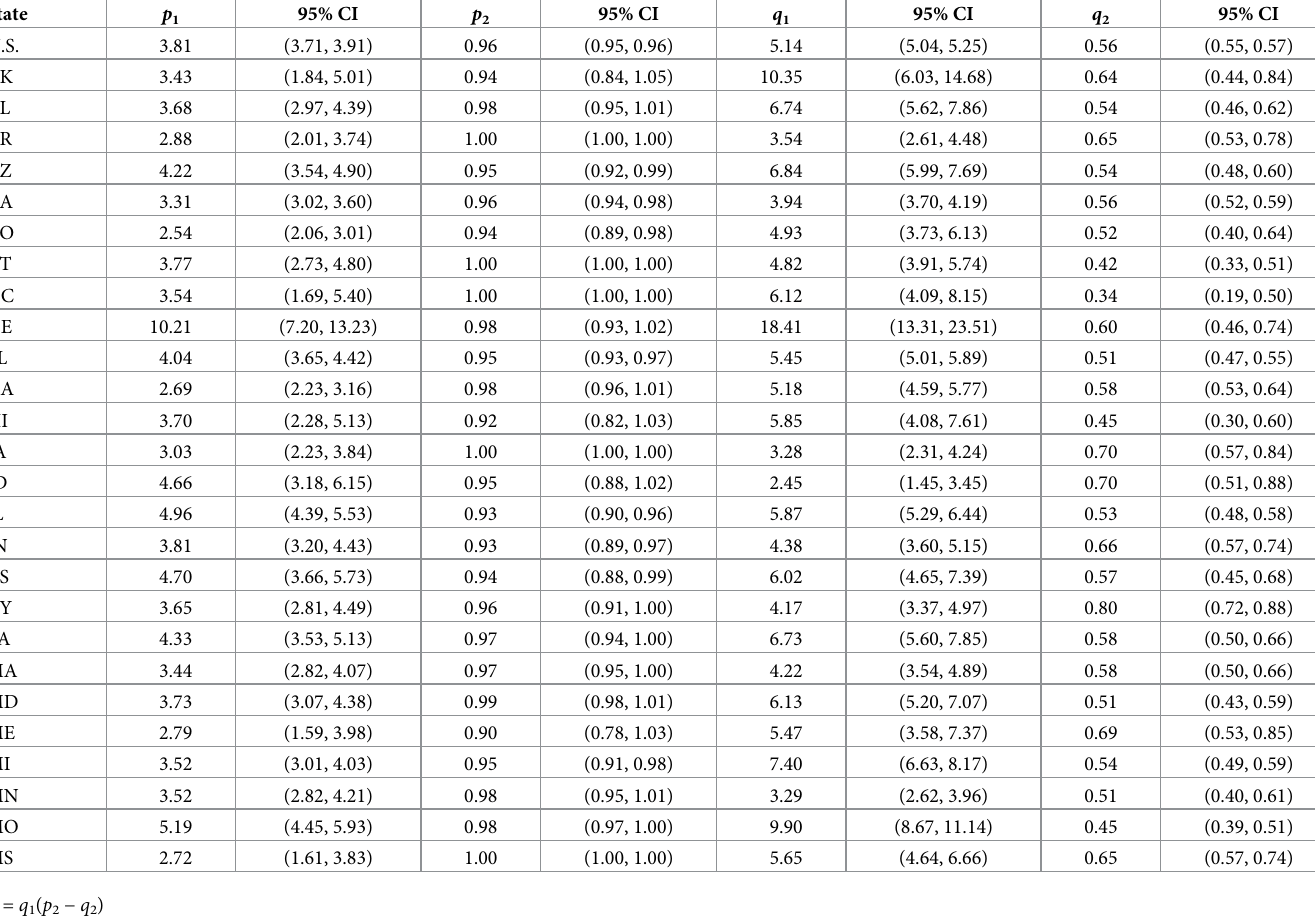
Table 4. Confidence intervals for p 1 , p 2 , q 1 , and q 2 ,